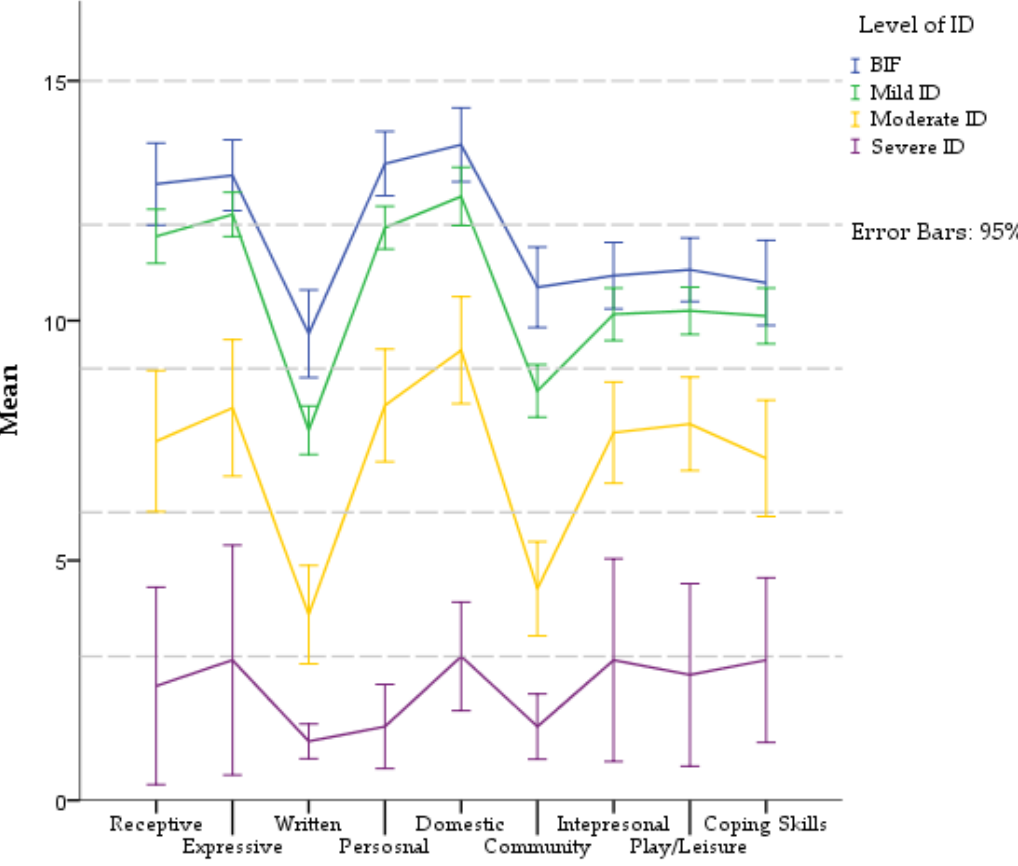
Figure 2. Profiles of AB (subdomains VABS-3) in different levels of ID. Communication domain includes the Receptive, Expressive, and Written subdomains. Daily Living Skills include the Per- sonal, Domestic, and Community subdomains. Socialization domain includes the Interpersonal,